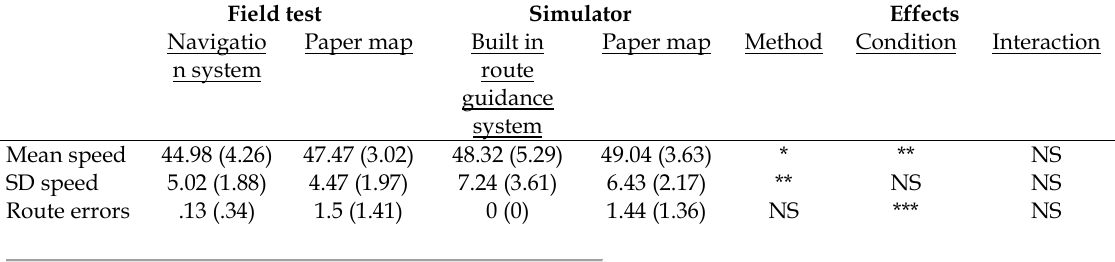
Table 3. Descriptive statistics of the several measures in the different conditions and